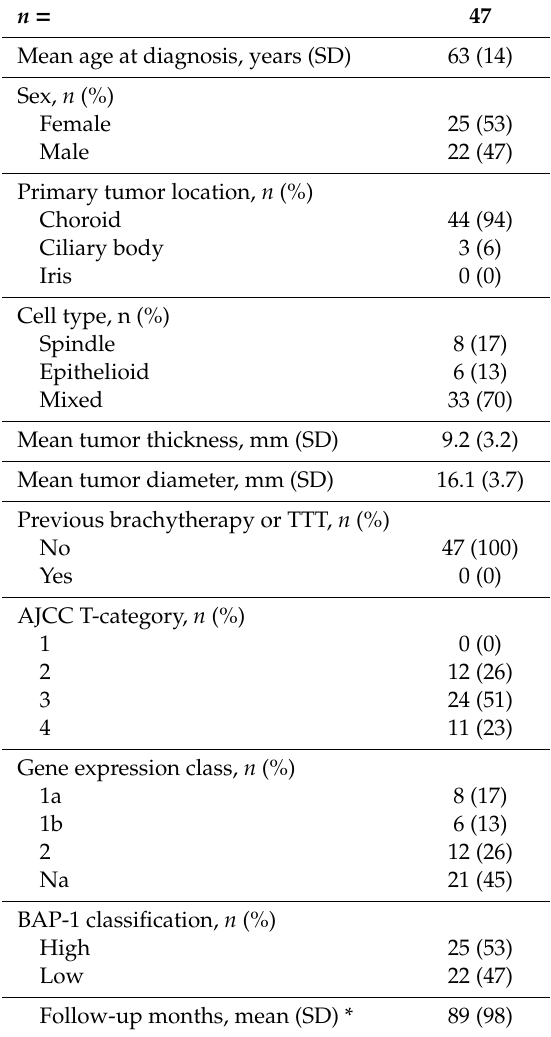
Table 1. Characteristics of patients and tumors included in this